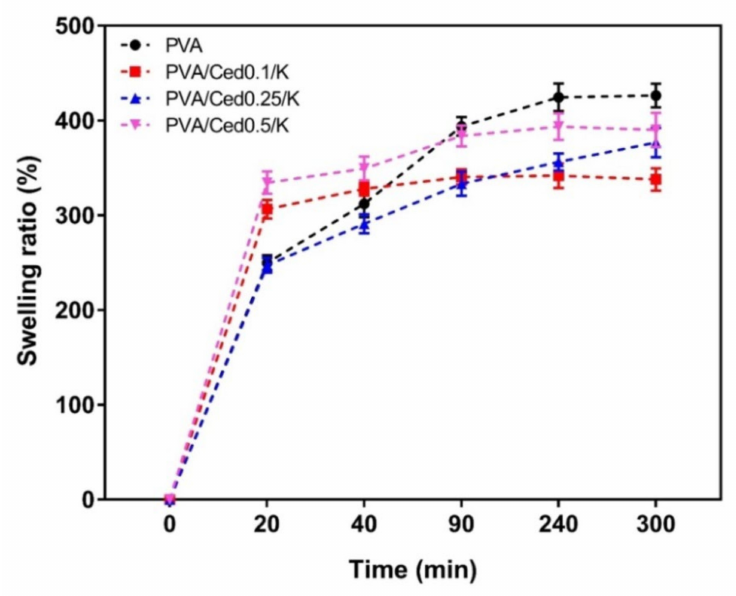
Figure 6. Dynamic water swelling profiles of PVA/Ced/K composite sponges. Results are shown as mean ±